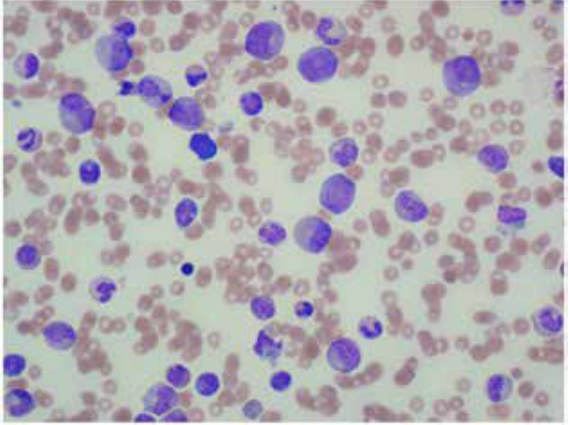
Figure 1: Peripheral blood smear of the patient at low (50 x) magnification showing various stages of maturation of the myeloid series, from promyelocytes to band cells and eosinophils. This is typical of chronic myeloid leukaemia. No platelets are visible.